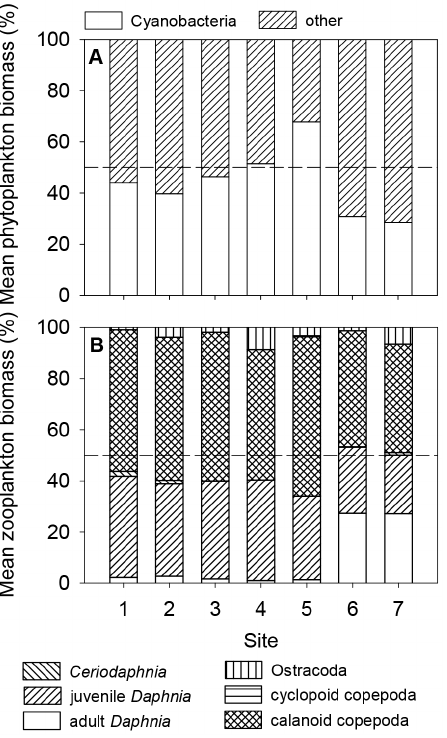
Figure 4. Biomass of phytoplankton and zooplankton groups averaged over time for each site. Dashed line indicates 50%. Bosmina biomass was omitted as it was , 1% at all dates.